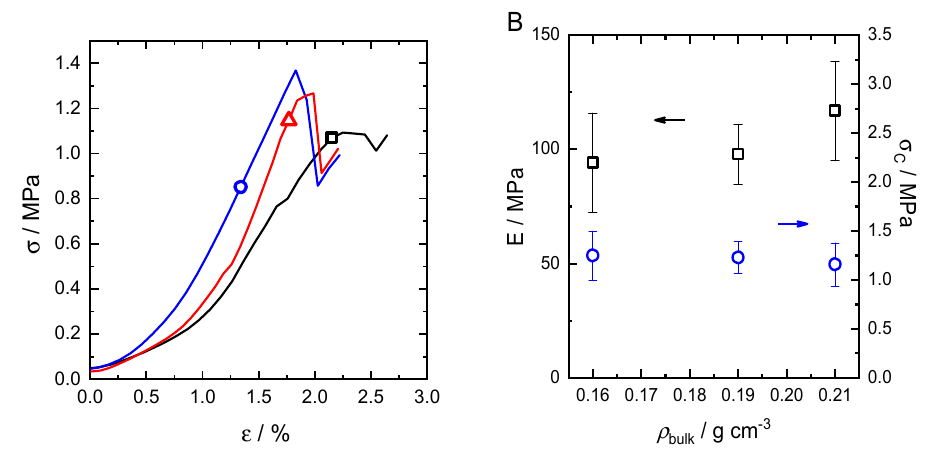
Figure 5. ( A ) Strain–stress curves of the materials submitted to compression: SucNaCl0.80 ( □ ), Suc- NaCl1.00 ( ○ ), and SucNaCl1.25 ( △ ). ( B ) Corresponding compression strength ( ○ ) and Young’s mod- ulus ( □ ) as a function of porosity.